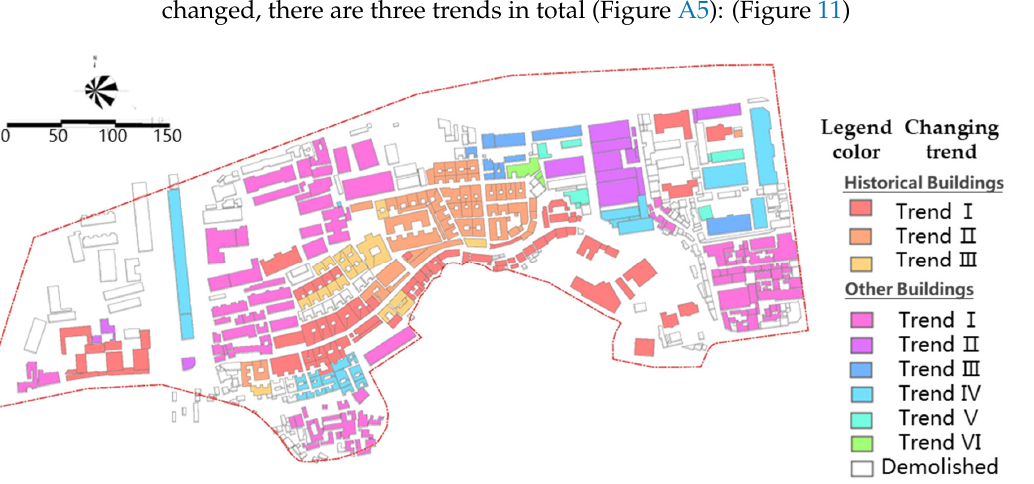
Figure 11. Changing trend of building